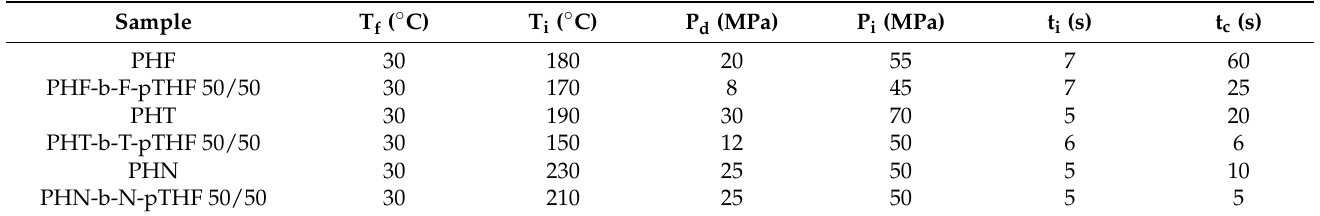
Table 2. Injection molding parameters of polyesters and copoly(ether-ester)s. Sample